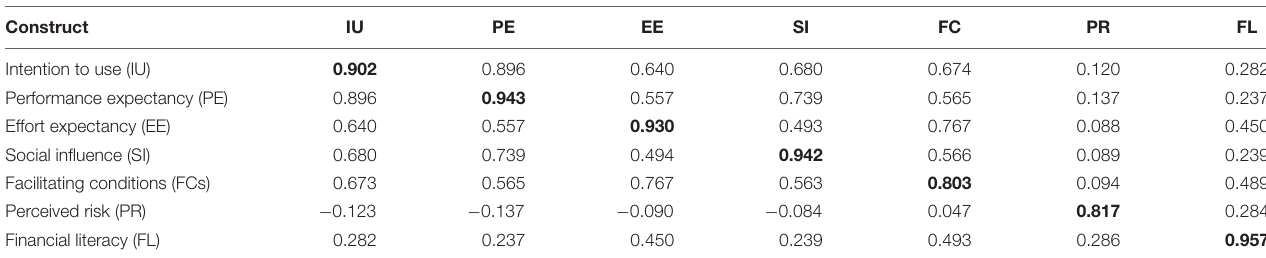
TABLE 4 | Divergent